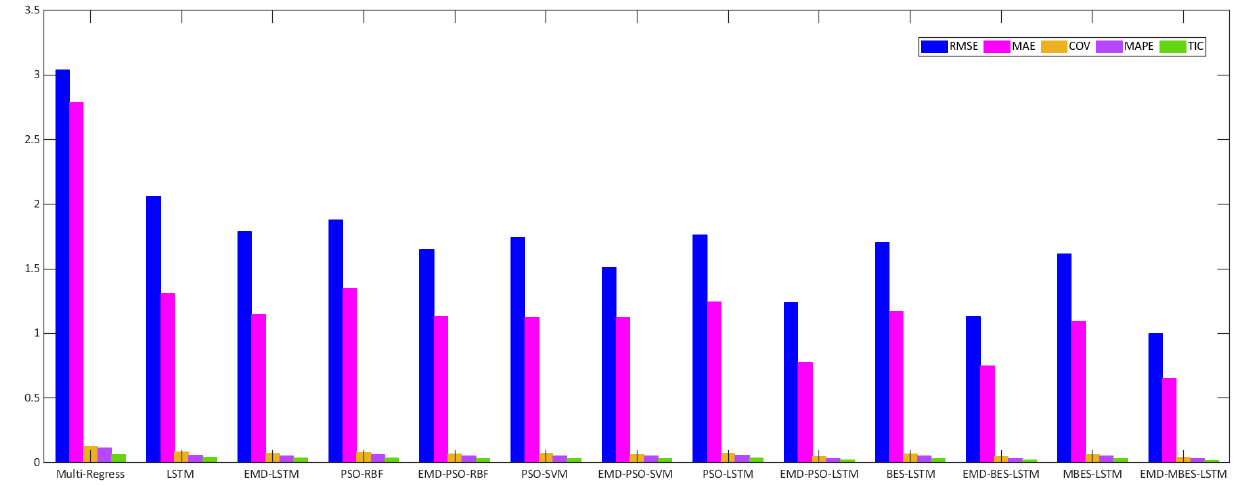
Figure 9. Evaluation error of different forecasting models.